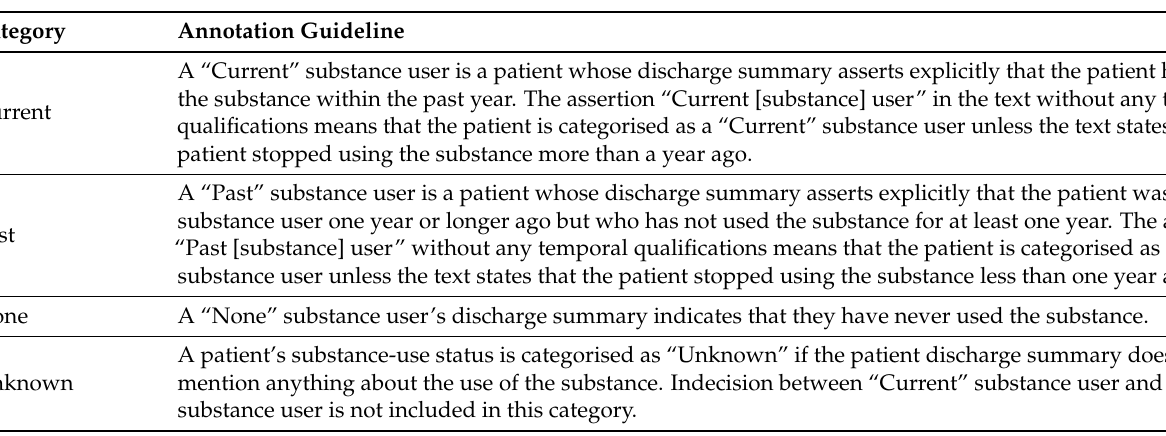
Table 1. Substance-use status annotation guidelines.